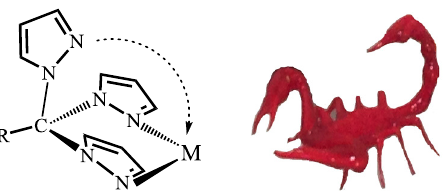
Figure 4. κ 2 – κ 3 interchange coordination modes of a tris(pyrazol ‐ 1 ‐ yl)methane scorpionate ligand and comparison with a scorpion.